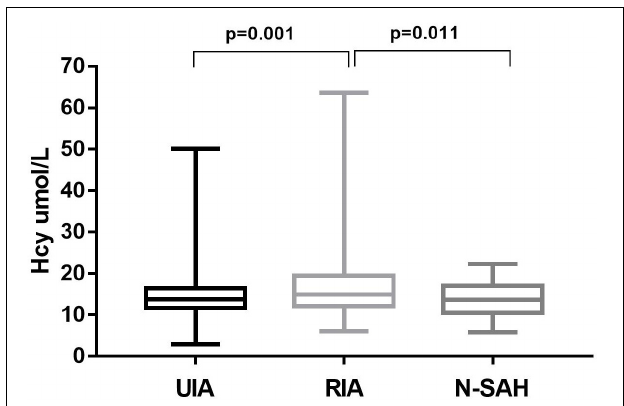
FIGURE 1 | Homocysteine levels of patients with unruptured and ruptured intracranial aneurysms. Hcy levels was higher in patients with RIA than in those with UIA; and in RIA was also higher than that in Na-SAH, the difference was statistically significant ( p = 0.001 and p = 0.011, respectively).